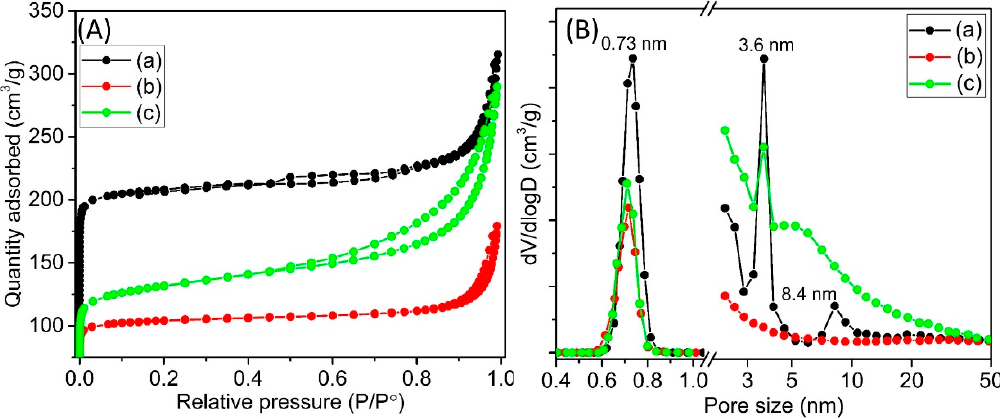
Figure 3. ( A ) N 2 sorption isotherms and ( B ) pore size distribution of (a) Y65, (b) IM-Y65, and (c) DP-Y65. Table 2. Surface acidity of Y65 and NiO-modified Y65.